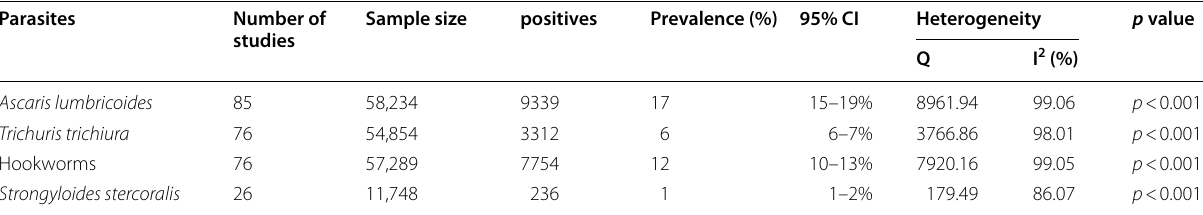
Table 8 summary of species-specific pooled prevalence estimates of STHs among Ethiopian children,